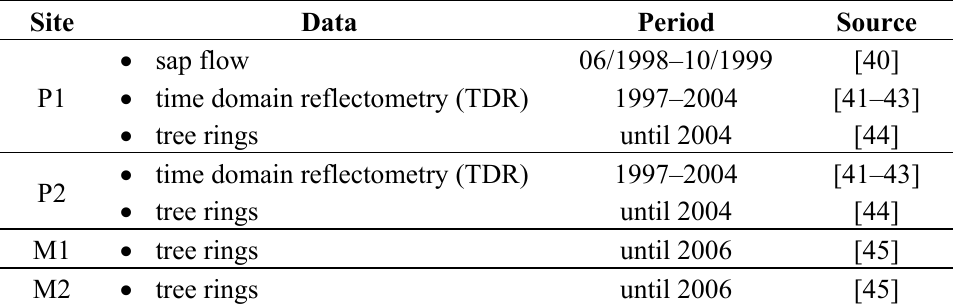
Table 4. Summary of data and measurement periods available for each forest stand considered in this